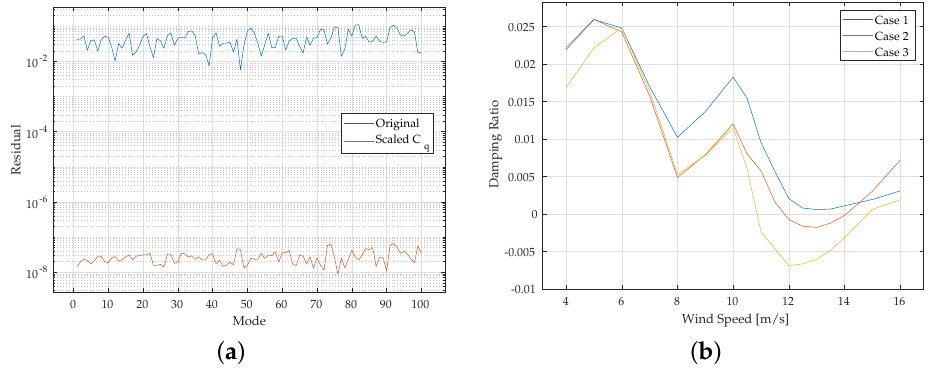
Figure 4. Wind turbine benchmark in different operating conditions. ( a ) Constraint matrix scaling effect. ( b ) Stability assessment.